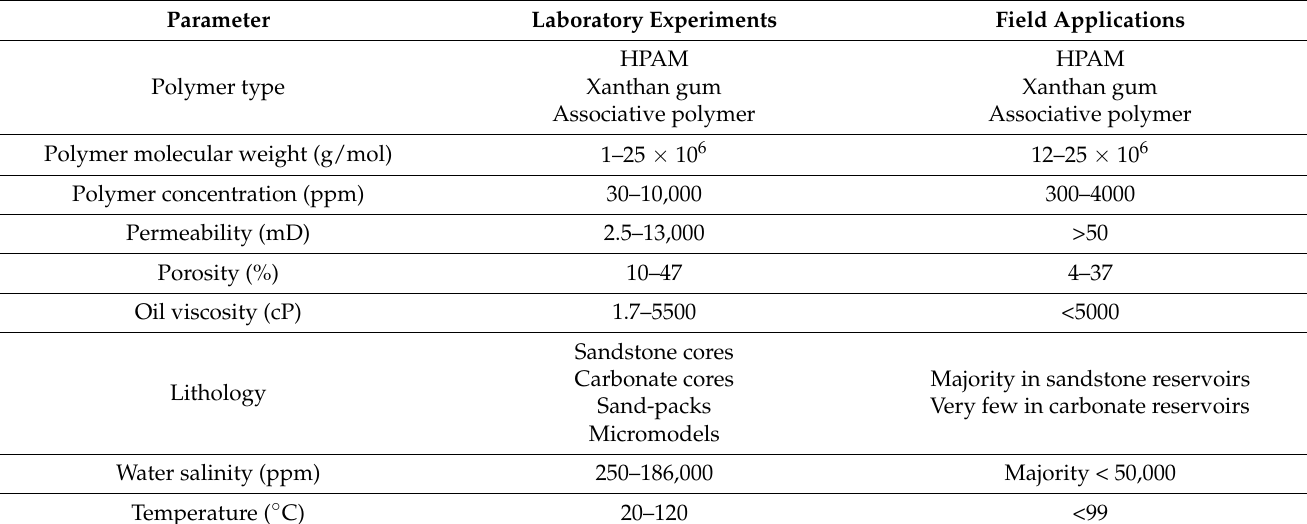
Table 2. Range of parameters for polymer flooding in laboratory vs. field applications